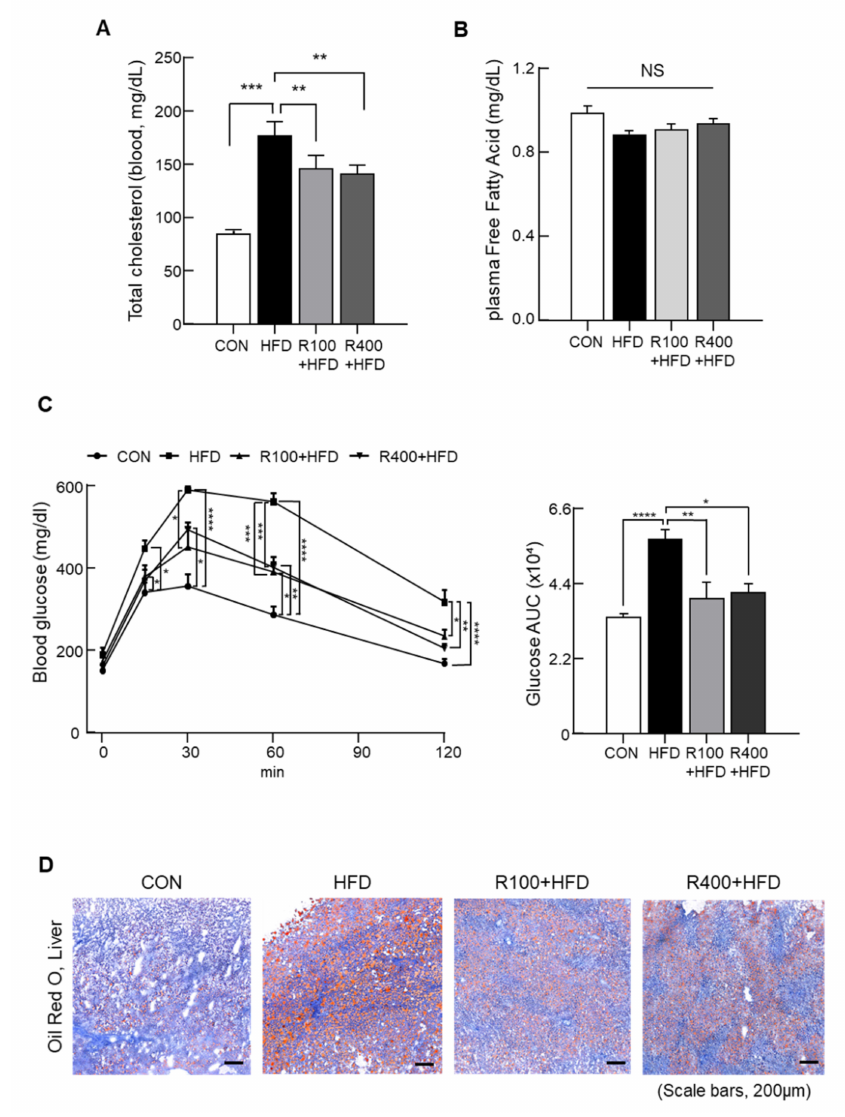
Figure 2. Improvement of blood metabolic parameters by R. fasciculatum. C57BL/6 mice (5 weeks old) were fed with chow diet (CON), high-fat diet (HFD, 45 kcal% fat diets), 100 mg R. fasciculatum (RF)/HFD kg (R100 + HFD), or 400 mg RF/HFD kg (R400 + HFD). The blood of these mice